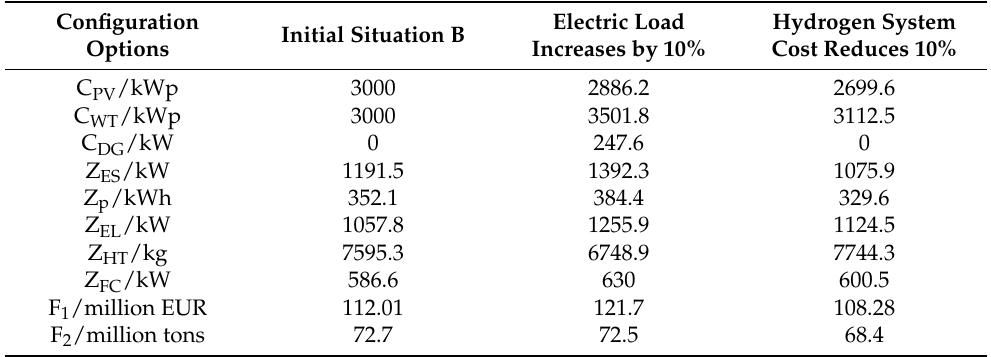
Table 10. Results of